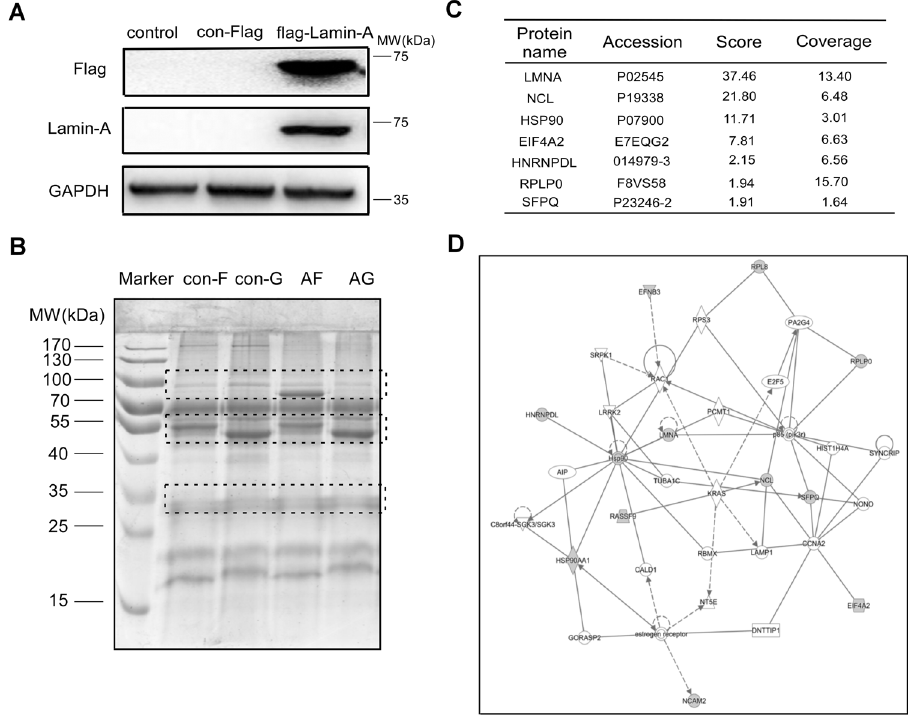
Fig. 1 Identi fi cation of lamin-A interacting proteins by MS. A Flag-lamin-A or con- fl ag was transfected into 293 T cells. The control was 293 T cells without transfection, and the con- fl ag was 293 T cells transfected with empty fl ag vector. Lamin-A level was detected by Western blotting, GAPDH was used as the endogenous reference protein. B 293 T cells were transfected with fl ag-lamin-A or con- fl ag plasmid and the cell lysates were co-immunoprecipitated by fl ag antibody or IgG antibody as control. Differential bands were shown in Coomassie staining SDS-PAGE gels. Con-F: fl ag antibody and 293 T cells transfected with con- fl ag, con-G: IgG antibody and 293 T cells transfected with con- fl ag, AF: fl ag antibody and 293 T cells transfected with fl ag-lamin-A, AG: IgG antibody and 293 T cells transfected with fl ag-lamin-A. C Top candidates of lamin-A interacting proteins identi fi ed by co-IP and MS analysis. Score: Protein scores, calculated by Proteome Discoverer application from a list of peptides, indicate the relevance of a protein. Coverage: Coverage of identi fi ed high-con fi dence peptides match the protein. D Network diagram of lamin-A interacting proteins by